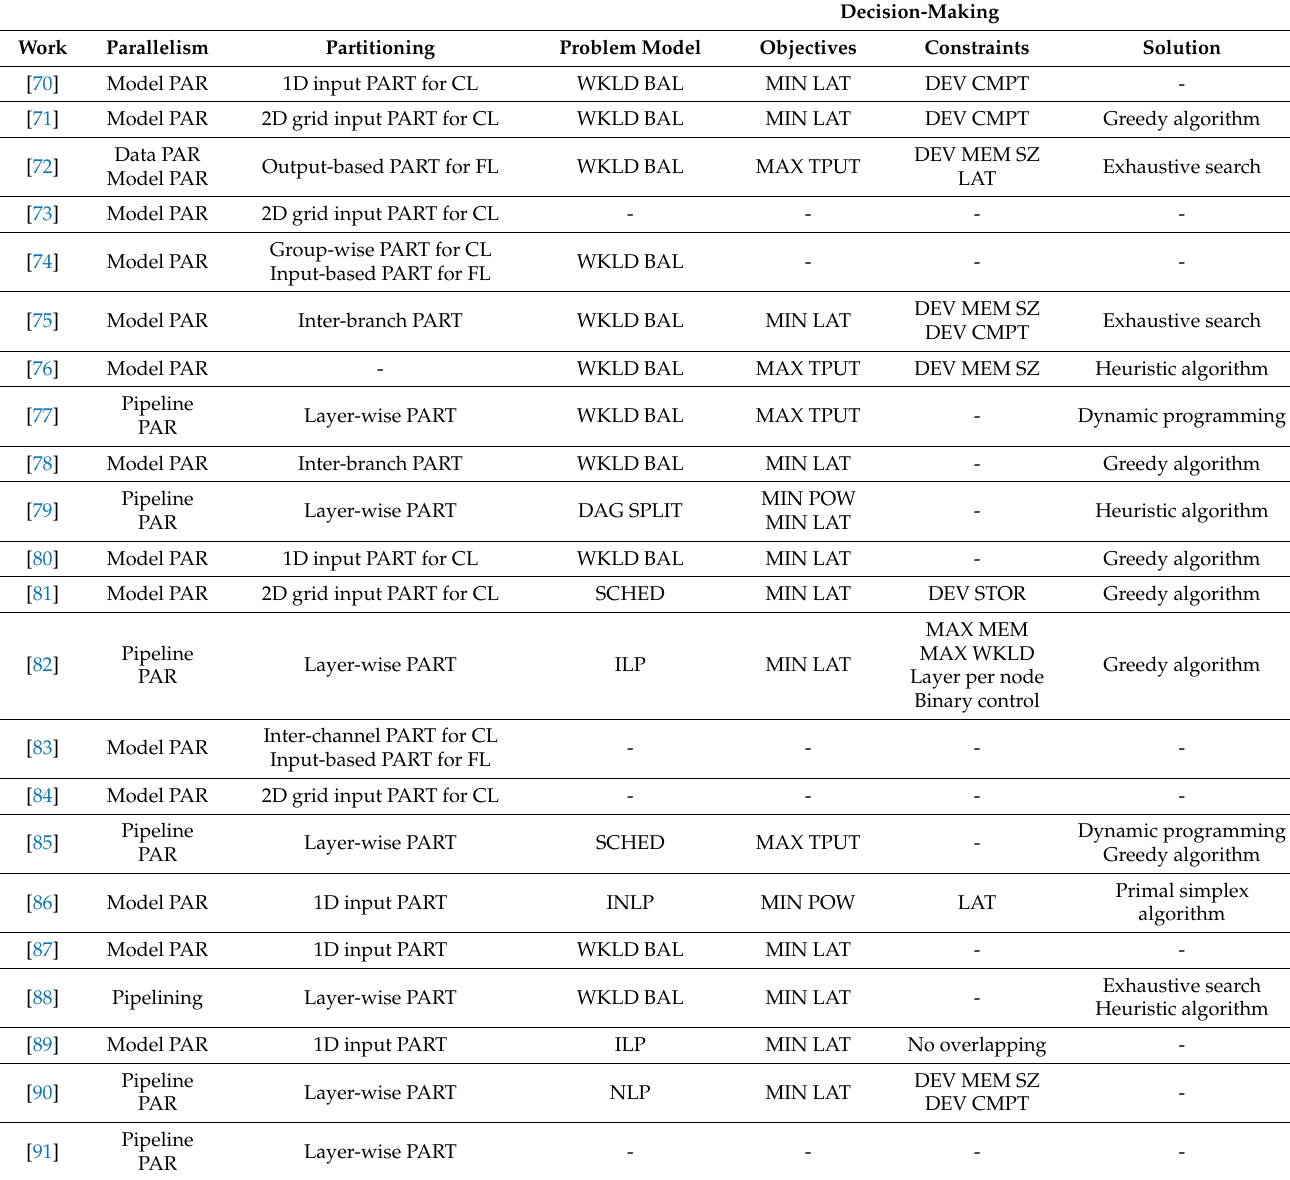
Table 3. Overview of the more relevant aspects of parallelism and partitioning for collaborative inference across IoT